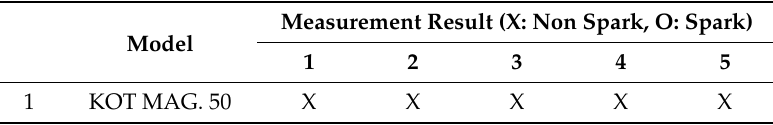
Table 8. Results of the free-drop spark